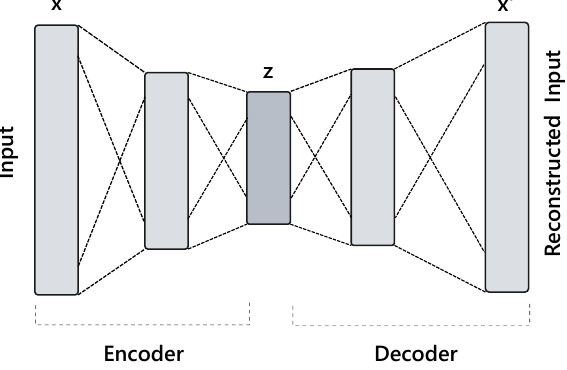
Figure 2. Illustration of an autoencoder